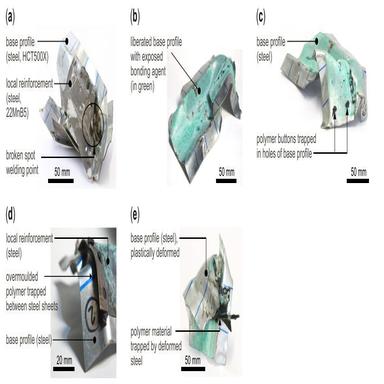
Examples of joint states after shredding: (a) broken spot welded point, (b) completely liberated steel base profile, (c) injected polymer buttons broken off the main polymer component but stuck in steel holes, (d) overmoulded polymer stuck between steel sheets, and (e) newly created steel-polymer joint: trapped polymer material within plastically deformed steel.